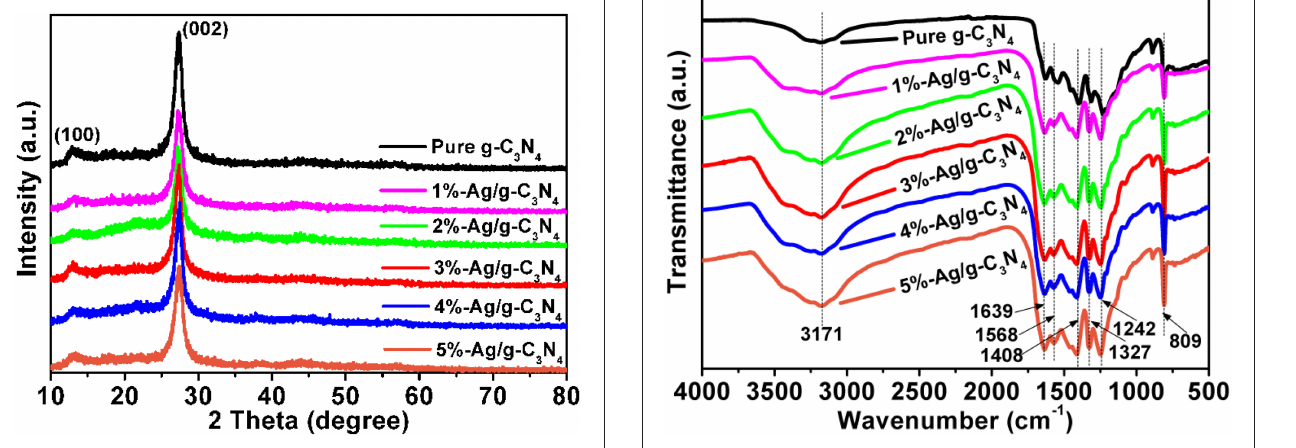
FIGURE 1 | XRD patterns of pure g-C 3 N 4 and Ag/g-C 3 N 4 samples. FIGURE 2 | FTIR spectra of pure g-C 3 N 4 and Ag/g-C 3 N 4